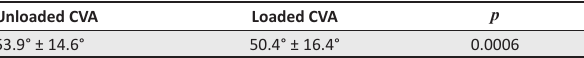
TABLE 4: Comparative analyses of craniovertebral angle during unloaded versus loaded phases of the 14